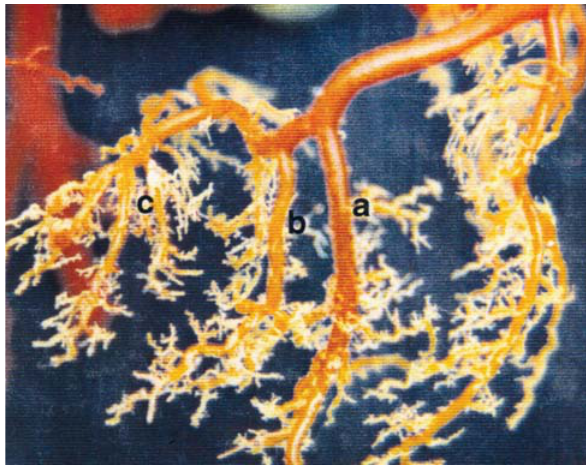
Fig. 3 - Dominância esquerda – a ,b, c: ramos interventriculares